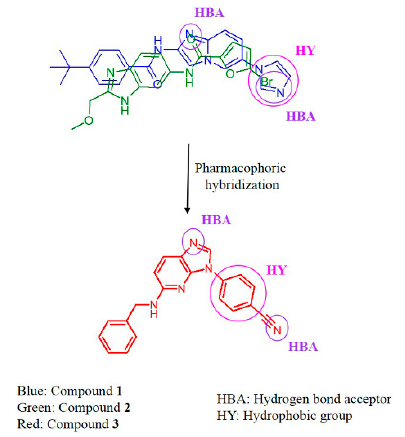
Figure 6. Design of a novel compound 3 from compounds 1 and 2 .